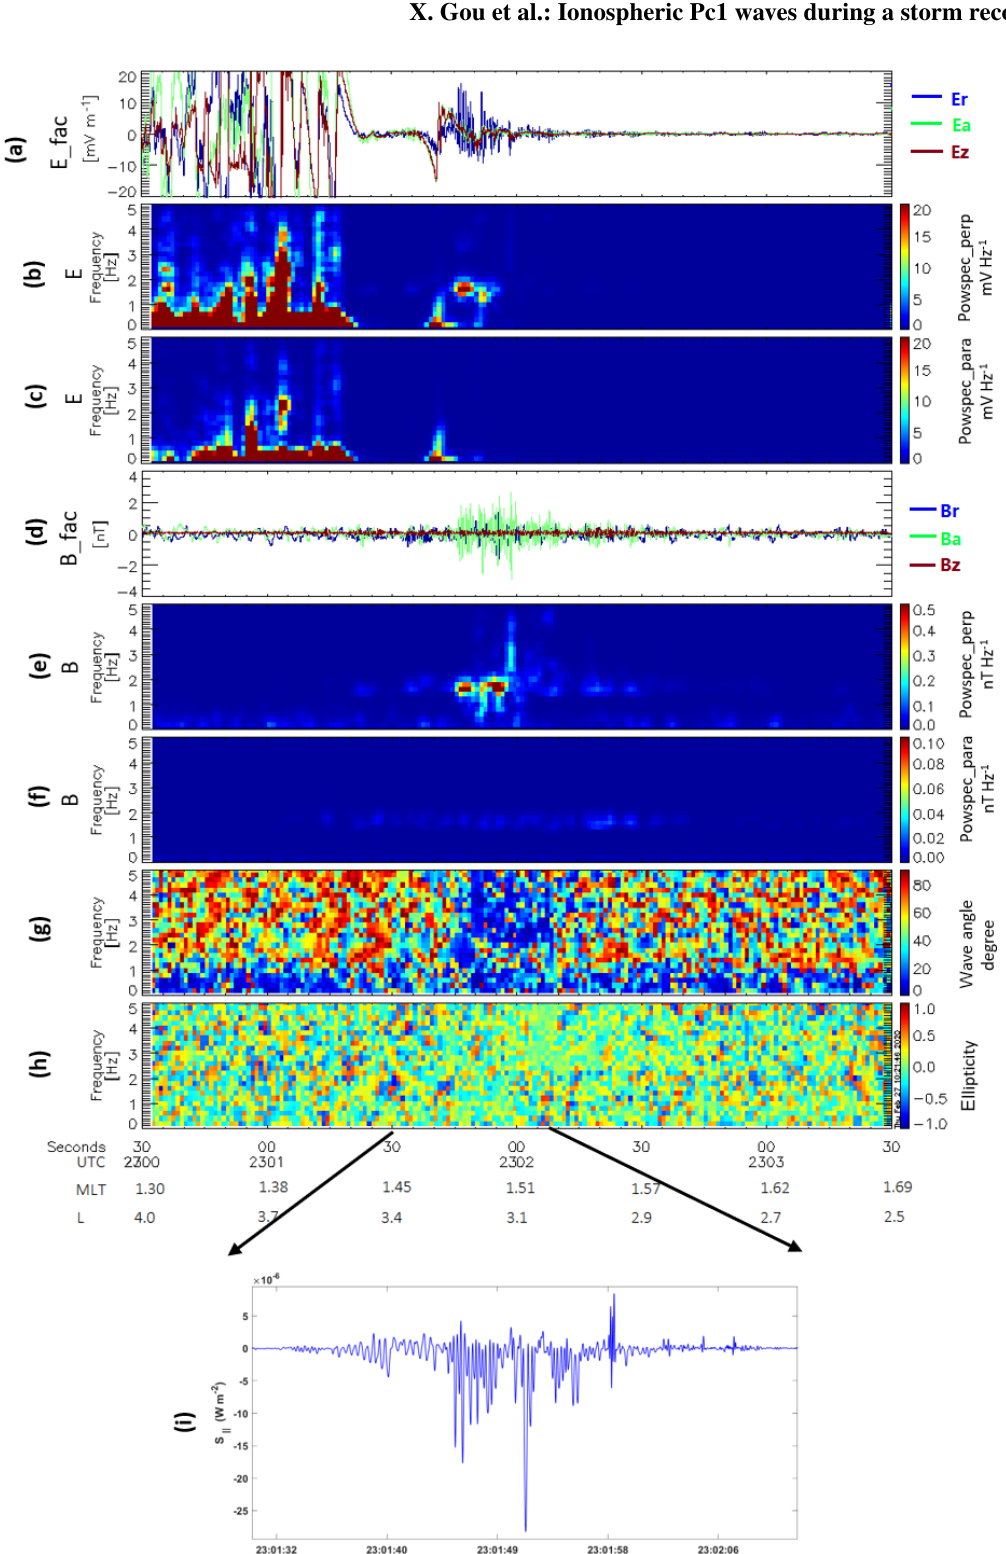
Figure 8. The wave propagation and polarisation features of the Pc1 waves observed by the CSES in the Southern Hemisphere. From top to bottom: (a) electric field components (including perpendicular components E a and E r marked in blue and green and the parallel component E z marked in red); electric wave power spectrum in (b) perpendicular and (c) parallel directions; (d) magnetic field components (including perpendicular components B a and B r marked in blue and green and the parallel component B z marked in red); wave power spectrum in (e) perpendicular and (f) parallel directions; (g) magnetic wave normal angle and (h) ellipticity; and (i) the field-aligned Poynting